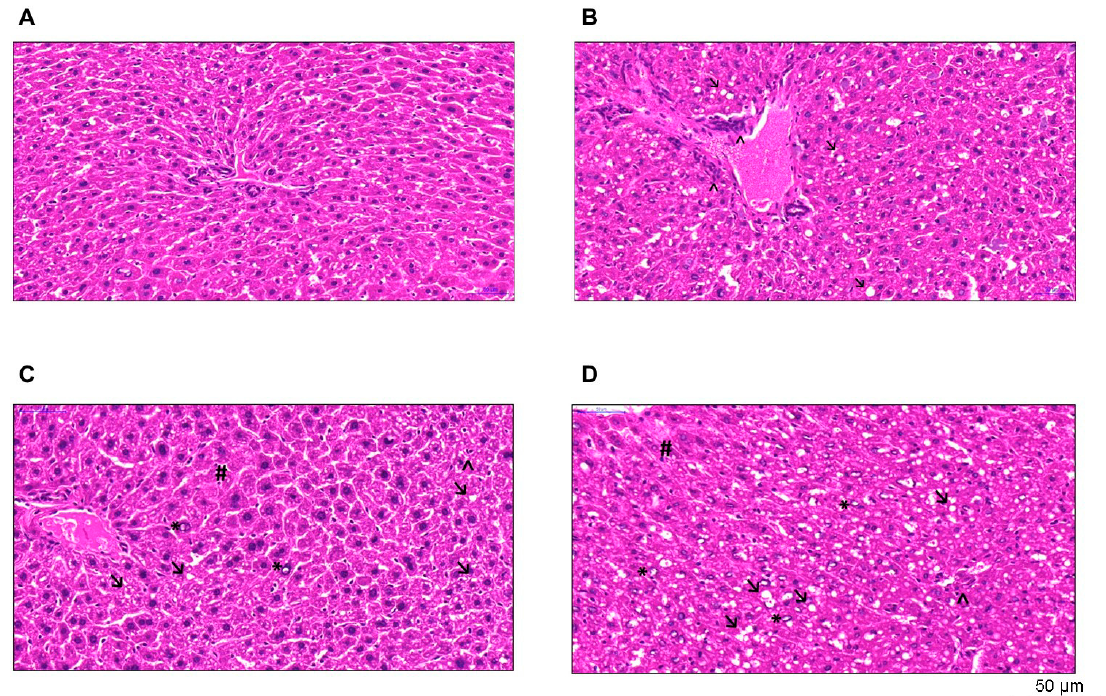
Figure 5. Histological analyses with a hematoxylin-eosin stain of the liver revealed damage induced by high-fat diets, according to the lipid offered: ( A ), control group; ( B ), olive oil group; ( C ), palm oil group; ( D ), hybrid palm oil group. Arrow: lipid vacuoles; Arrowhead: inflammatory infiltrate; Asterisk: nuclear vacuolization; Hash symbol: hydropic degeneration. Table 2. NAFLD (nonalcoholic fatty liver disease) activity score (NAS) based on histological analyses. Group Grade of Steatosis Grade of Lobular